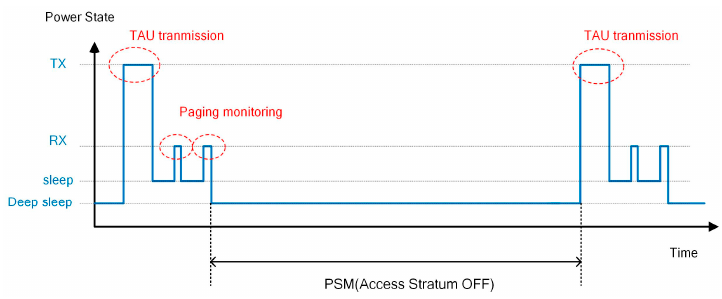
Figure 6. UE power state in power saving mode (PSM).